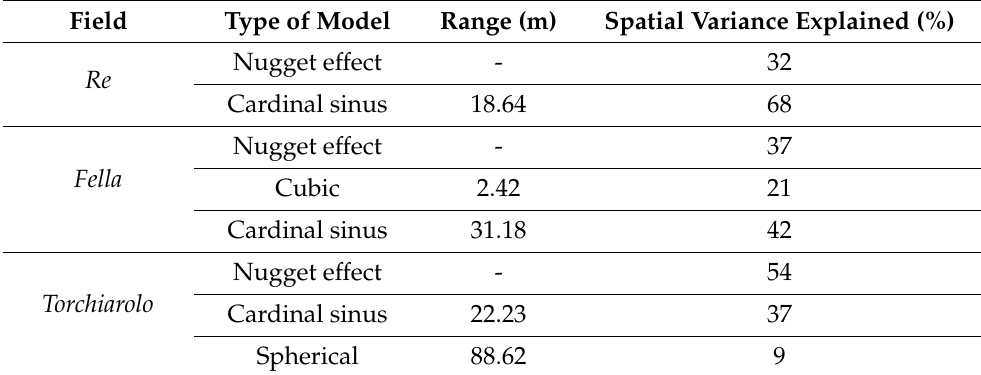
Table 1. The characteristics of the linear models of co-regionalization